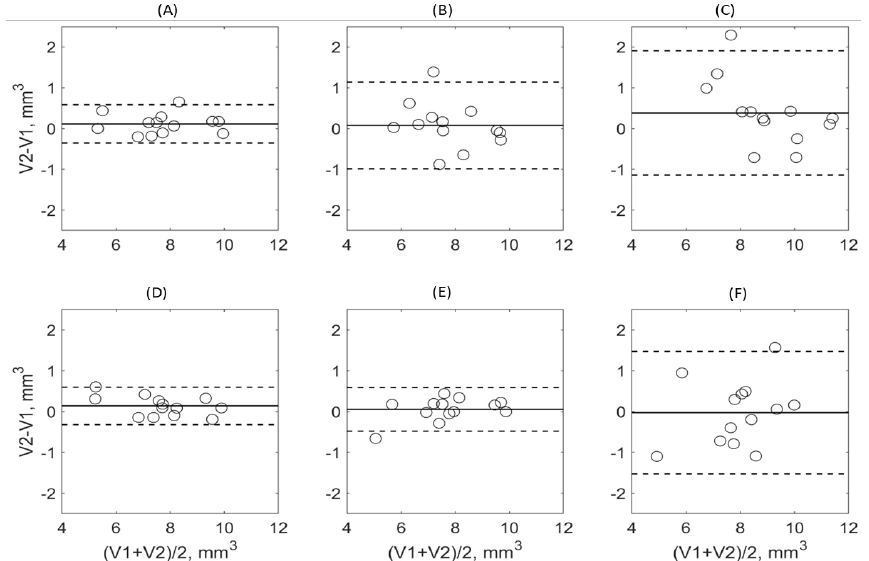
Figure 6. Bland–Altman (BA) analysis of the scan–rescan (test–retest) tibia volumes in the test dataset for different A-U-net training scenarios (( A ) full training set; ( D ) half-split 1; ( E ) half-split 2; ( F ) single-mouse) and human expert annotations (( B ) EA1; ( C ) EA2) segmentations. Solid horizontal lines mark the observed average bias of the volume difference, while dashed lines mark corresponding 95% limits of agreement.